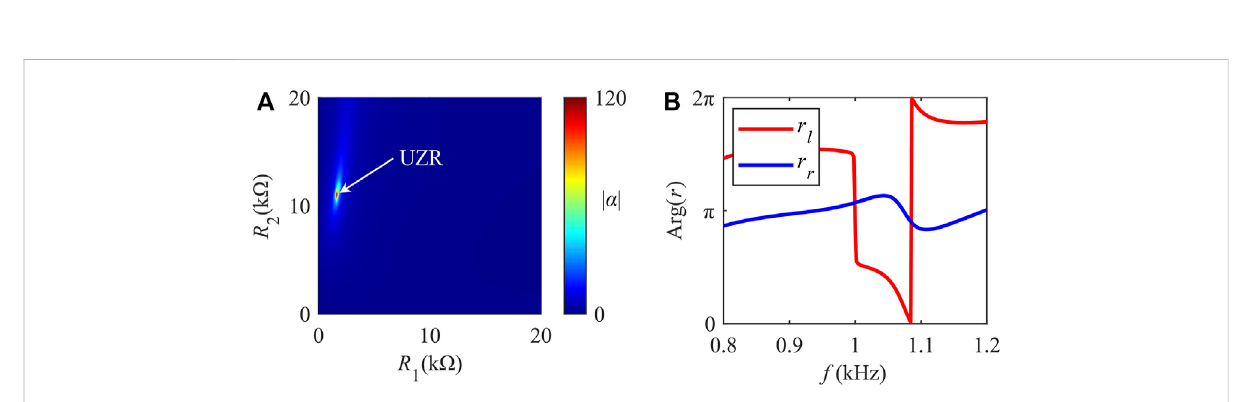
FIGURE 3 (A) | α | varying with resistances R